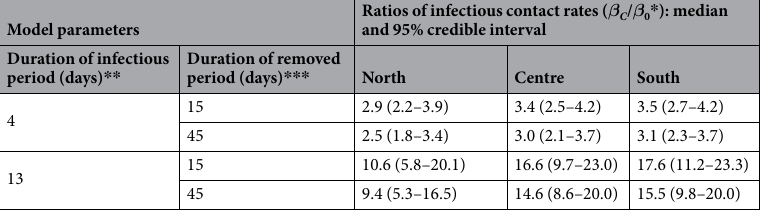
Table 2. Ratios between inter-farm AI infectious contact rates during and outside the Lunar New Year period selected through Approximate Bayesian Computation (ABC) in the three climatic regions of Vietnam * β C : Infectious contact rate during the at-risk period (Lunar New Year). β 0 : Infectious contact rate outside the at-risk period. ** Period from infection of farm birds to farm clearing. *** Period from farm clearing to repopulation.